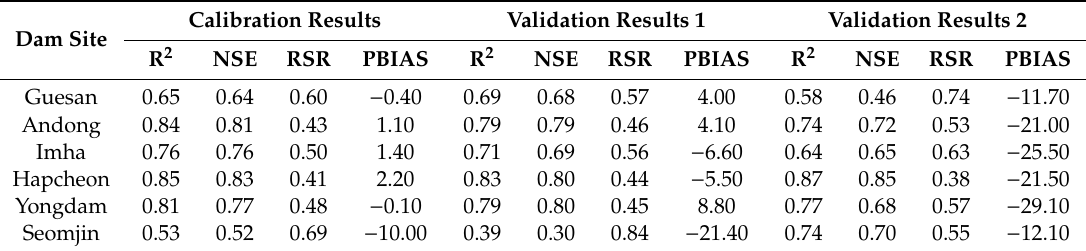
Table 5. Calibration and validation statistics of the SWAT model for 6 dam sites.